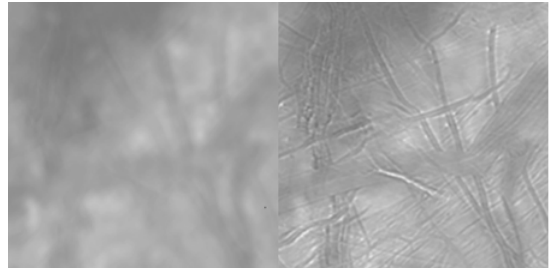
Figure 5. Subarea (105 km square) of the albedo maps used in image simulation, shown at full resolution. Left: baseline map derived from 1570 m/pixel albedo image interpolated to 210 m/pixel (Fig. 1b). Right: